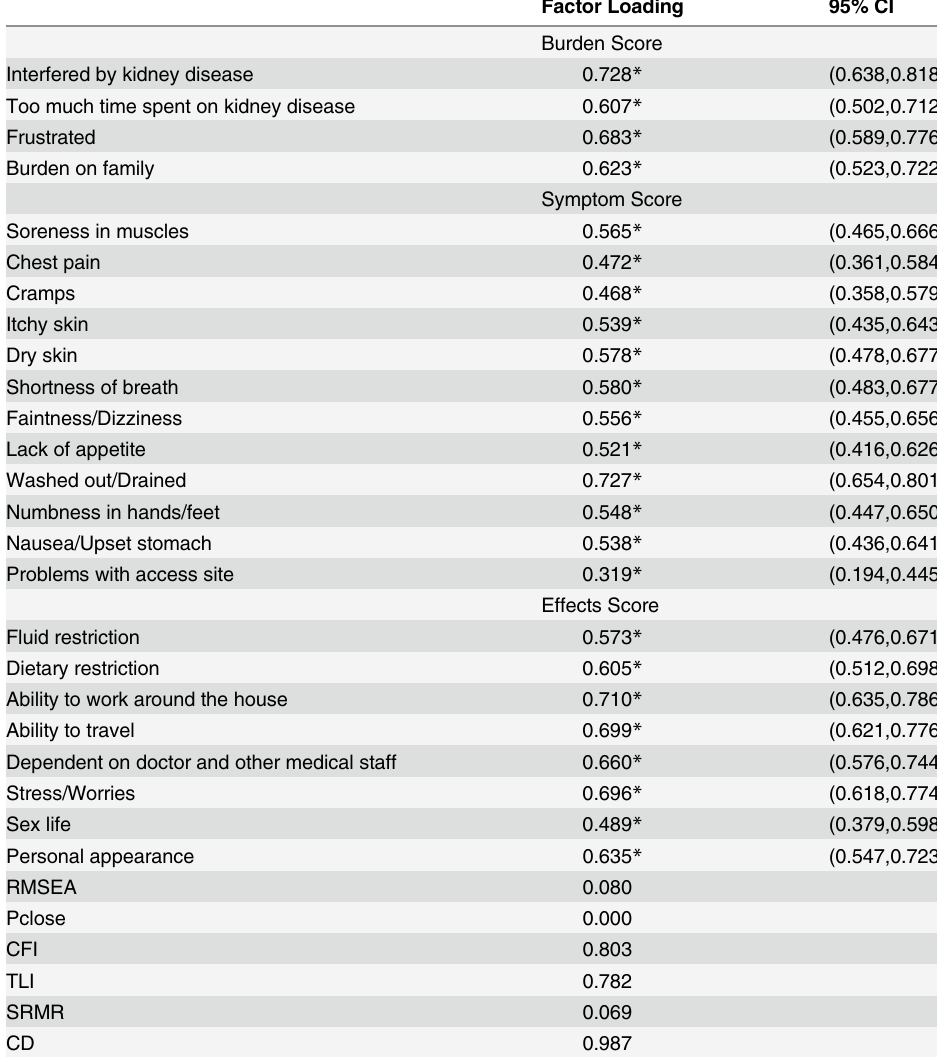
Table 4. Confirmatory factor analysis of the disease-specific domain of